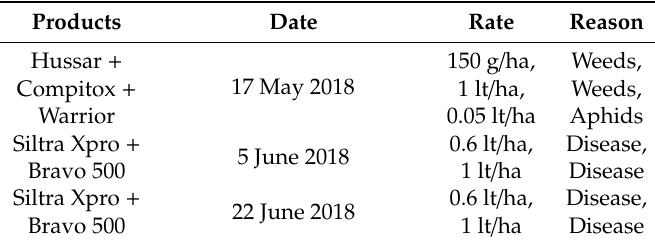
Table A2. Crop protection program.